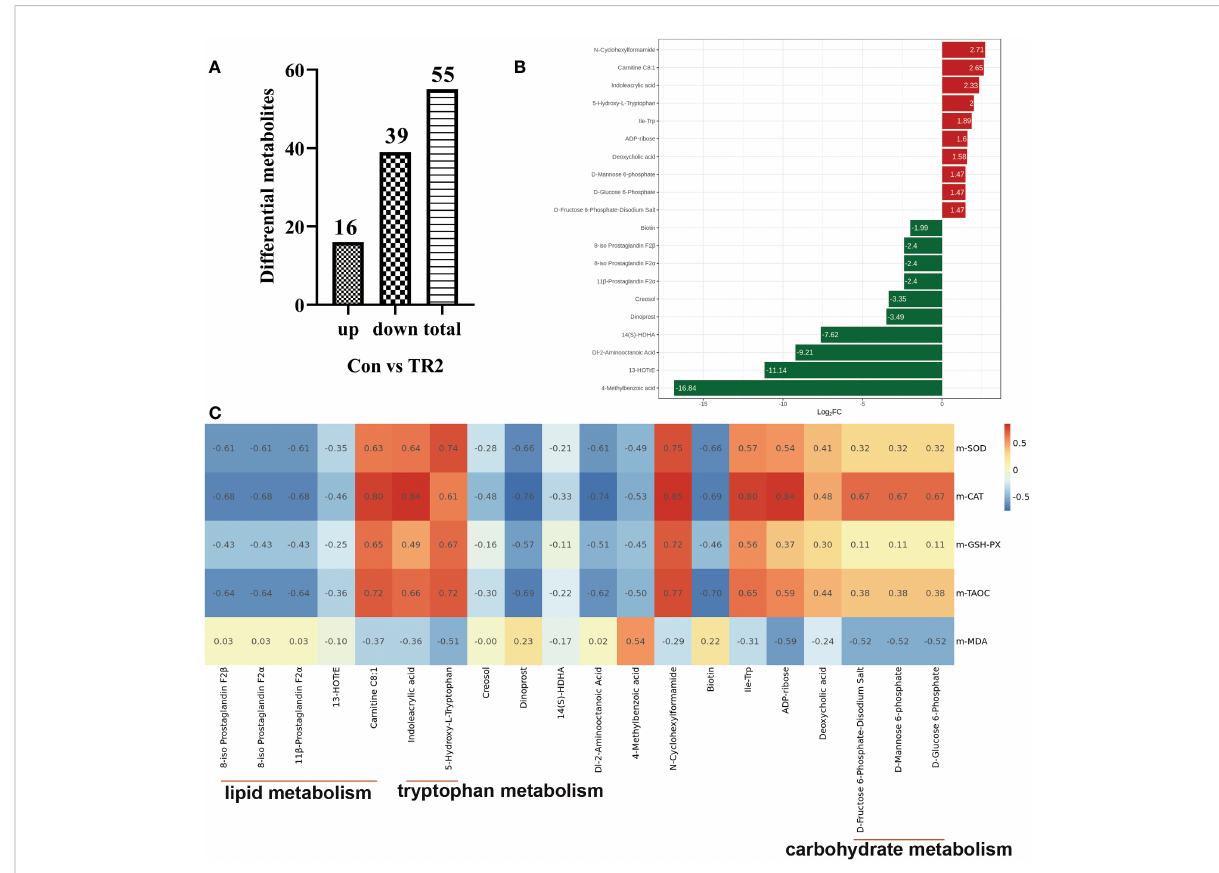
FIGURE 2 DEMs from Con vs. TR2. Upregulated, downregulated and total numbers of DEMs from Con vs. TR2 (A) , the 20 leading DEMs from Con vs. TR2 (B) , a correlation heat map between the 20 leading DEMs from Con vs. TR2 and their indexes of antioxidant performance (C)